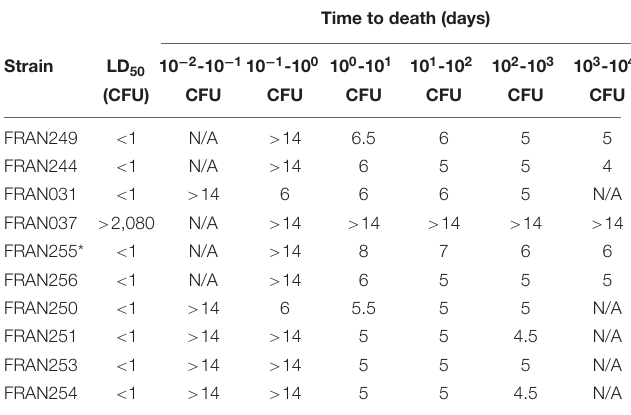
TABLE 4 | Mouse intranasal LD 50 and TTD